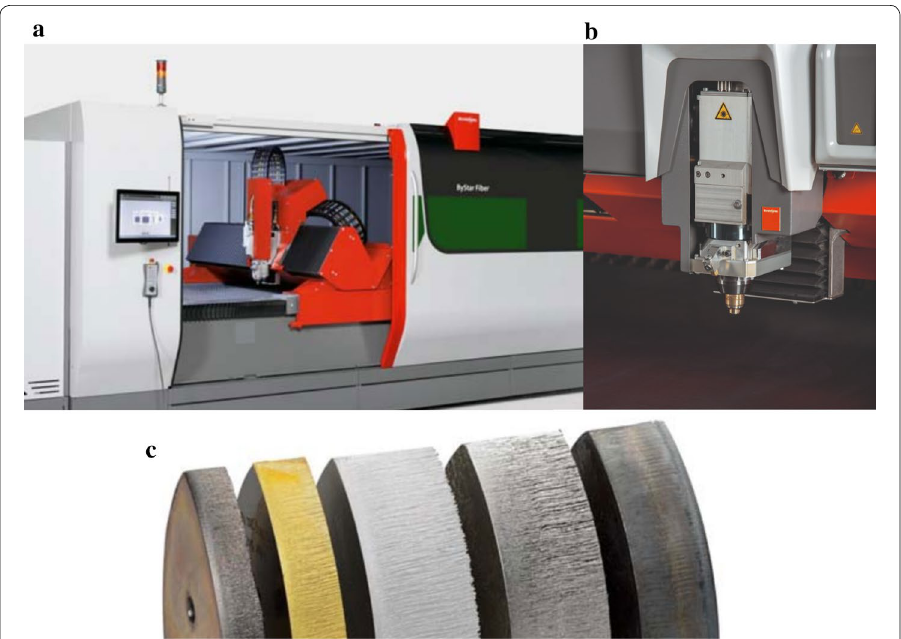
Fig. 1 Intelligent maintenance: a A laser cutting machine, b the cutting process and c examples of materials and